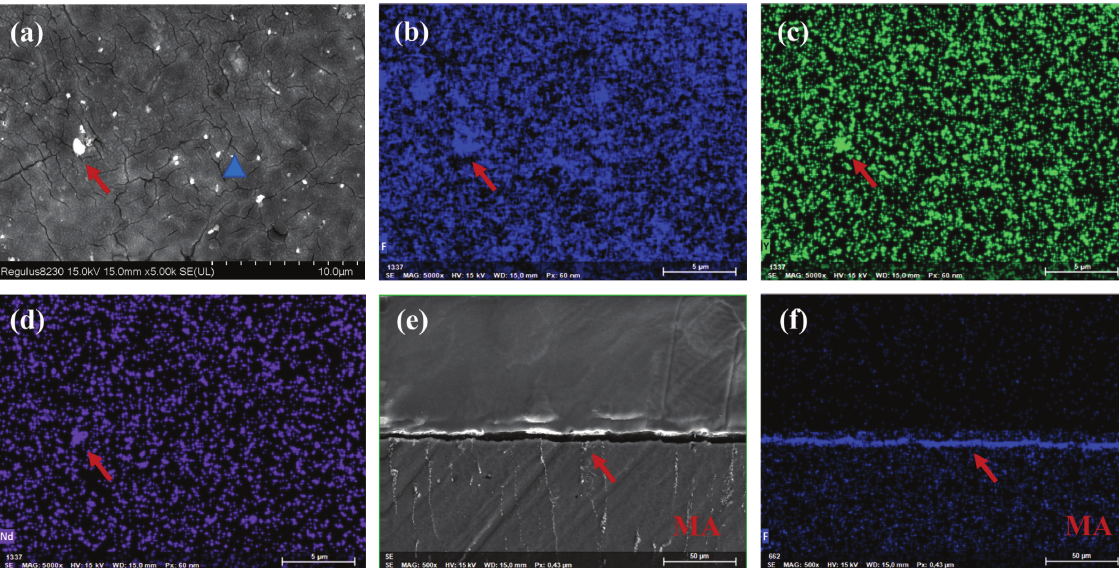
Figure 3: Surface (5000x magnification) and cross section (500x) of SEM images and EDS of coatings fabricated on MAR-Gide. (a–d) The coating on MAR-Gide is uniform. Some particles composed of rare-earth elements are partially scattered on the surface (red arrow). Cracks of width < 0.2 μ m are distributed uniformly (blue triangle). (e, f) A fluorinated film of thickness ∼ 3 μ m (red arrow) on MAR-Gide is uniform.